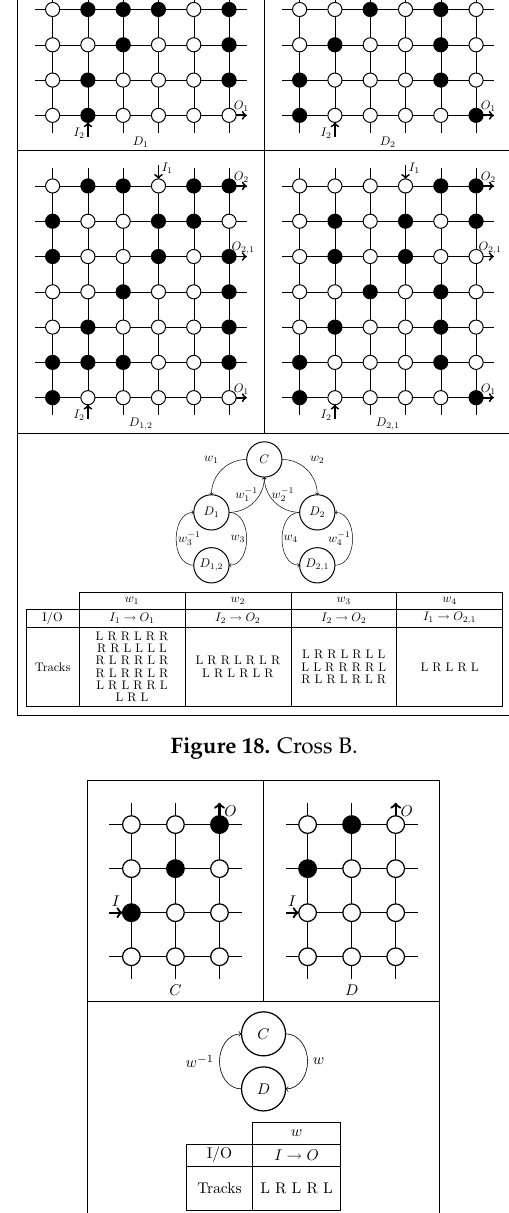
Figure 19. Cross